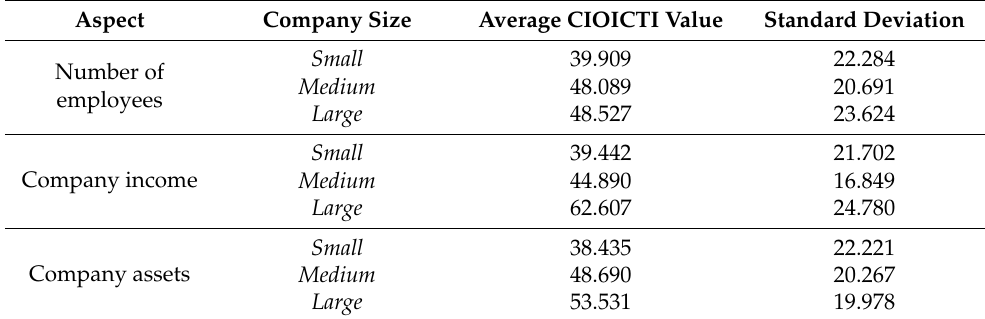
Table 8. Average values of CIOICTI with respect to the company size.